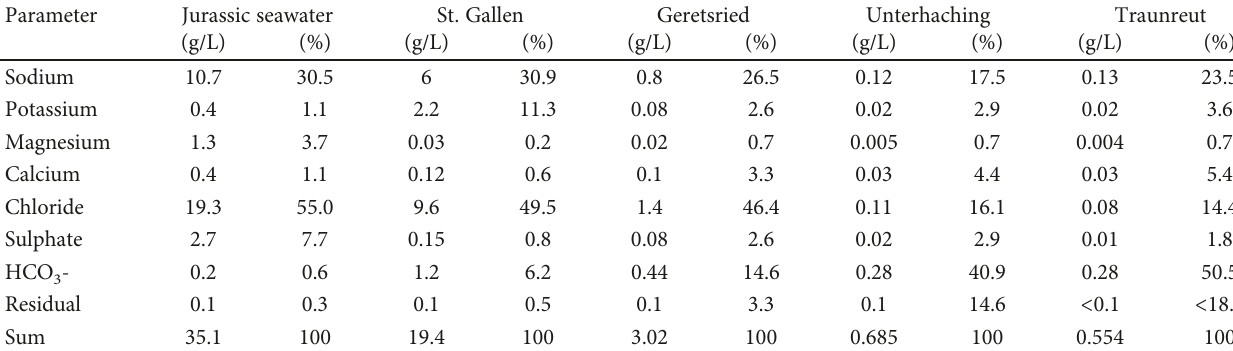
Table 4: Hydrochemical data from the deep wells showing a dilution of the Jurassic seawater from the St. Gallen well [61], Geretsried, Unterhaching, and the most diluted formation water at the Traunreut well. Parameter